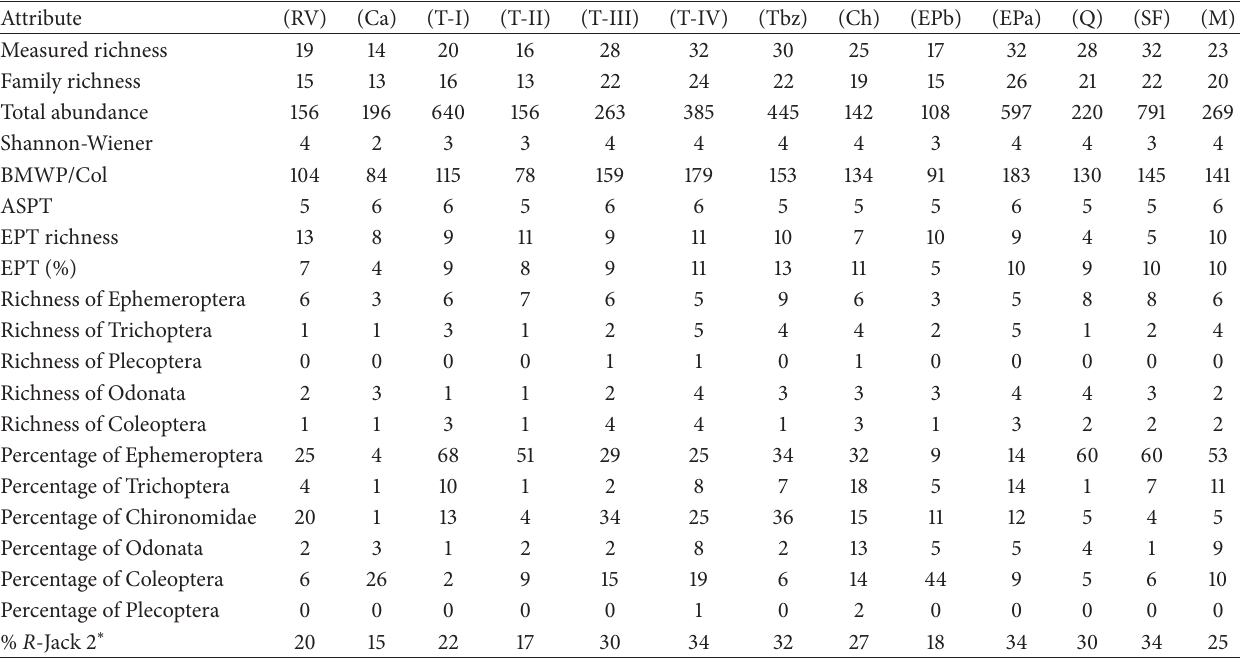
∗ % R -Jack 2 is the percentage of richness measured in relation to the regional richness estimation (Jack 2 = 93 taxa). Abbreviations for study areas are as in Table